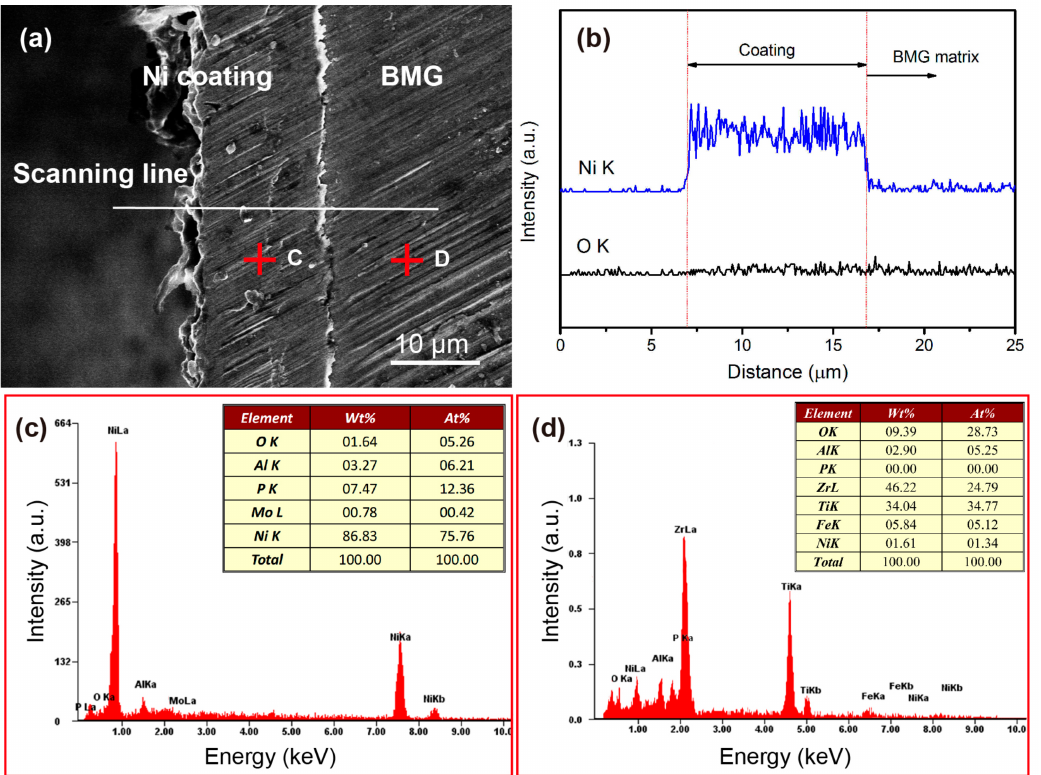
Figure 3. ( a ) Typical SEM image of the cross-section of the coated bulk metallic glasses (BMG) rod; ( b ) energy dispersive spectrometer (EDS) line scanning results performed along the white line marked in ( a ); ( c ) EDS spectrum of the point testing performed on cross C in ( a ); and, ( d ) EDS spectrum of the point testing performed on cross D in ( a ) together with the corresponding elemental analysis